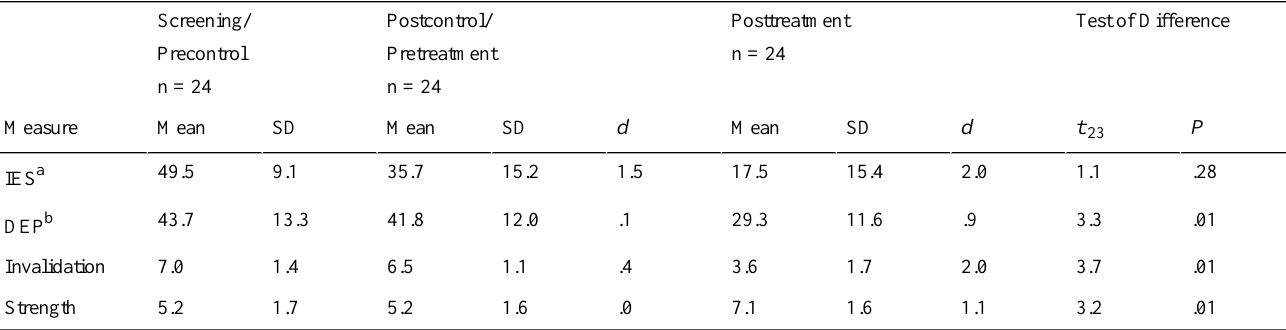
Table 2. Means and standard deviations of outcome measures administered at the screening, at postcontrol period, and at posttreatment, effect sizes d, and t values resulting from the paired t tests of the differences in improvement during control and during treatment Test of DifferencePosttreatment 24Postcontrol/ n =